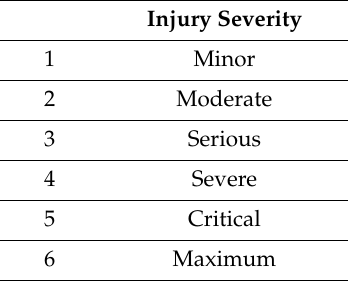
Table 1. The severity of the Abbreviated Injury Scale